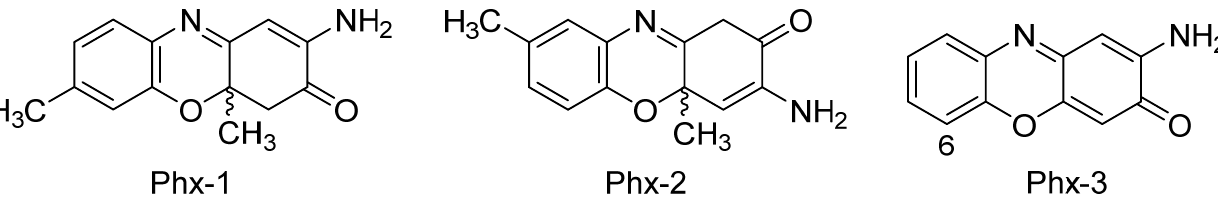
Figure 3. Most studied aminophenoxazinones: 2-amino-4,4 α -dihydro-4 α ,7-dimethyl-3 H -phenoxazin-3-one (Phx-1), 3-amino- 1,4 α -dihydro-4 α ,8-dimethyl-2 H -phenoxazin-2-one (Phx-2) and 2-aminophenoxazine-3-one